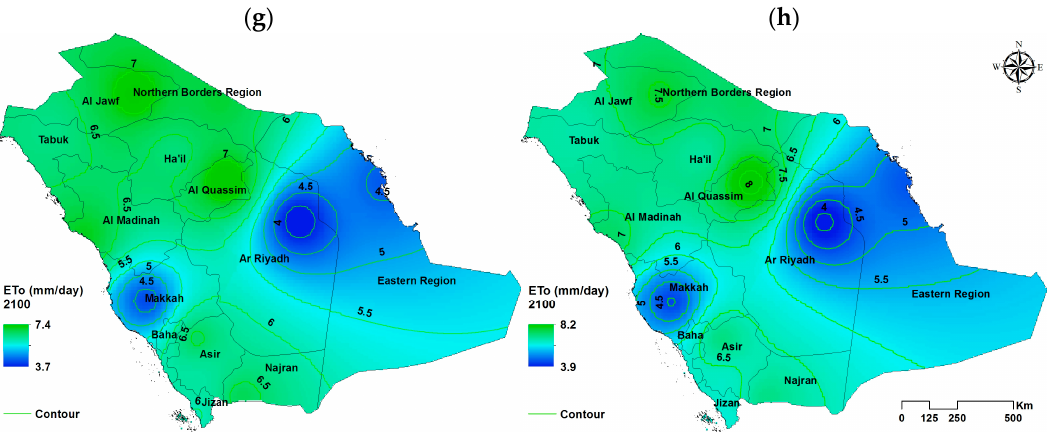
Figure 6. Annual-averaged ETo (mm/day) under SSP2-4.5 on the left for ( a ) 2040, ( c ) 2060, ( e ) 2080, and ( g ) 2100 and SSP2-8.5 on the right for ( b ) 2040, ( d ) 2060, ( f ) 2080, and ( h ) 2100, using average data from the four CMIP6 climate models.